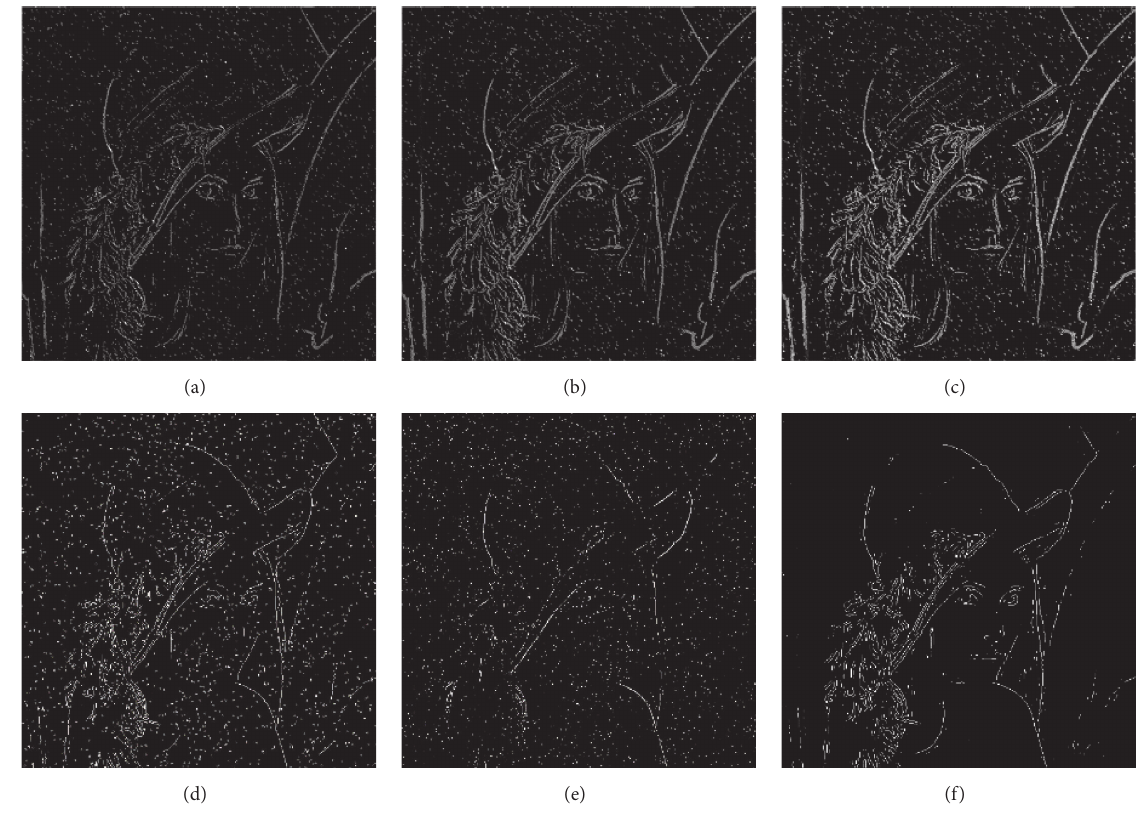
Figure 14: Lena with 1% salt and pepper: (a) SOM, (b) MOM, (c) LOM, (d) Sobel, (e) Roberts, and (f)